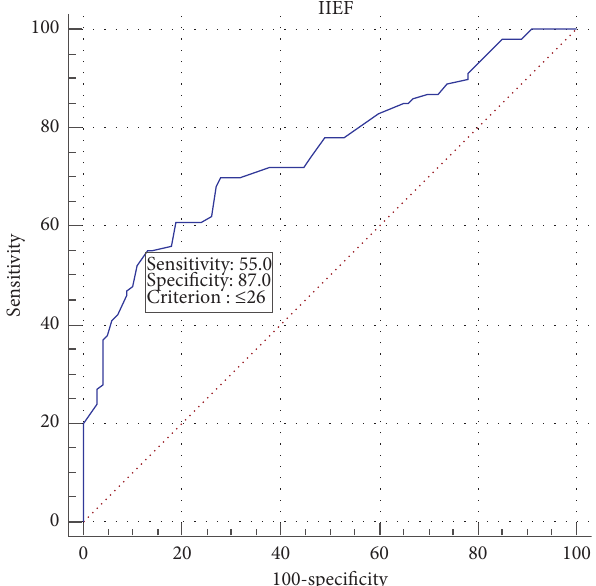
Figure 2: ROC curve for the IIEF score. The optimal cutoff point for IIEF was 26. Area under the ROC curve (AUC) was 0.750 with 95% CI (0.648–0.808) and P < 0 . 001. The sensitivity and specificity of IIEF as a screening test was 55% and 87%, respectively. Note: area under the curve indicates the predictive power. Predictive power will be high if it is far from 0.5 value (close to 1